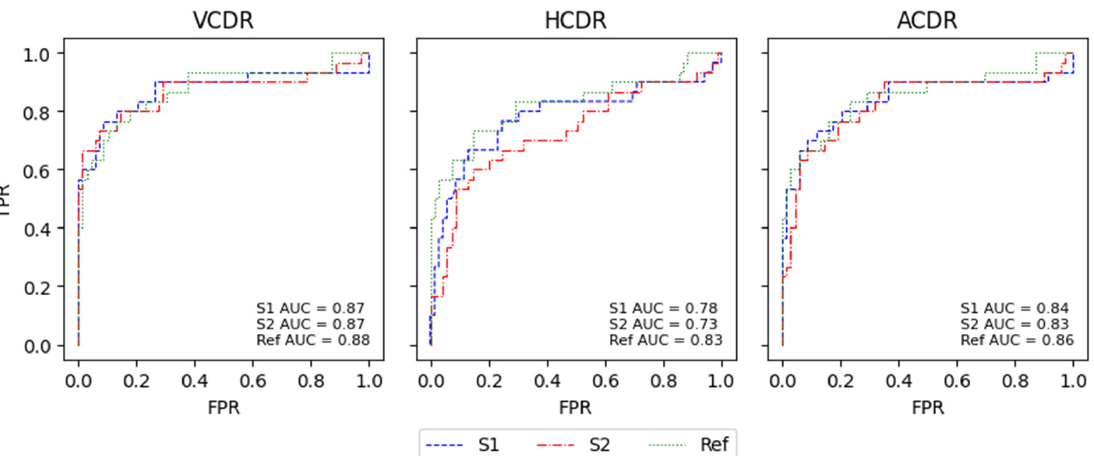
Figure 8. ROC curves for the glaucoma classification through CDR calculation for K-Fold CVDB with the S1 and S2 models and with the respective CDR calculations with the Ref masks.